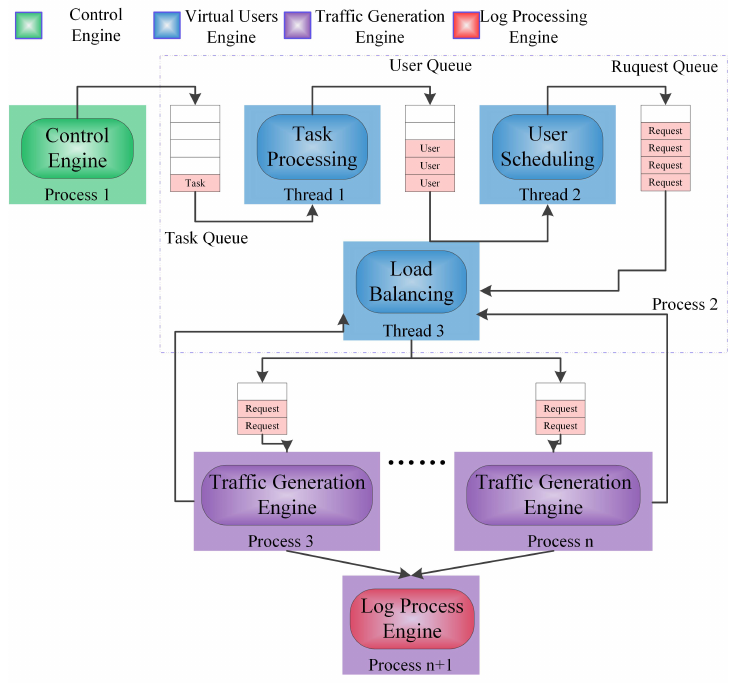
Figure 6. Parallel